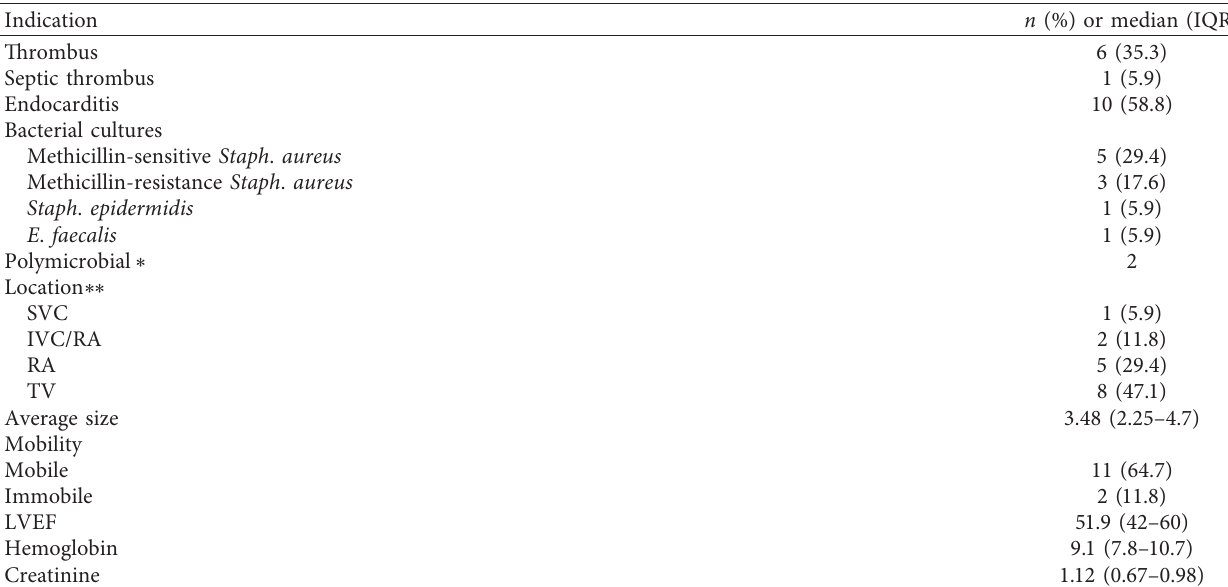
Table 2: Preoperative